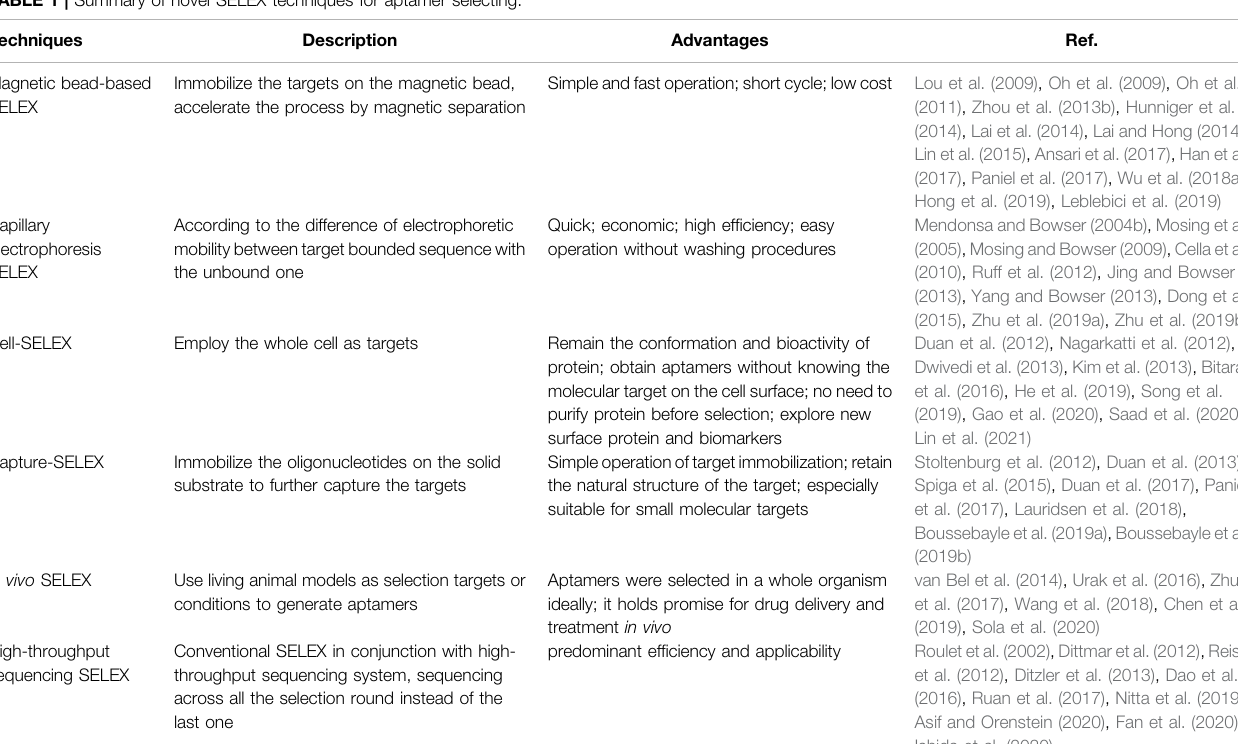
TABLE 1 | Summary of novel SELEX techniques for aptamer